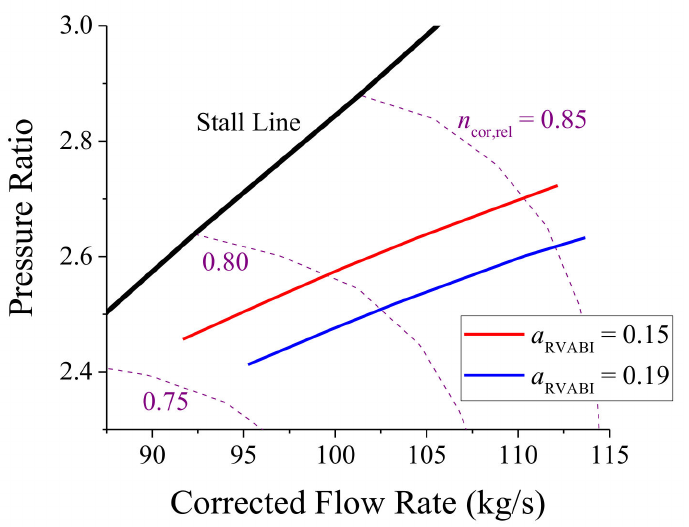
Figure 32. The Variations of the Matched Operating Lines of Front Fan at the conditions of Different Area Coefficients of RVABI ( α RVABI ).